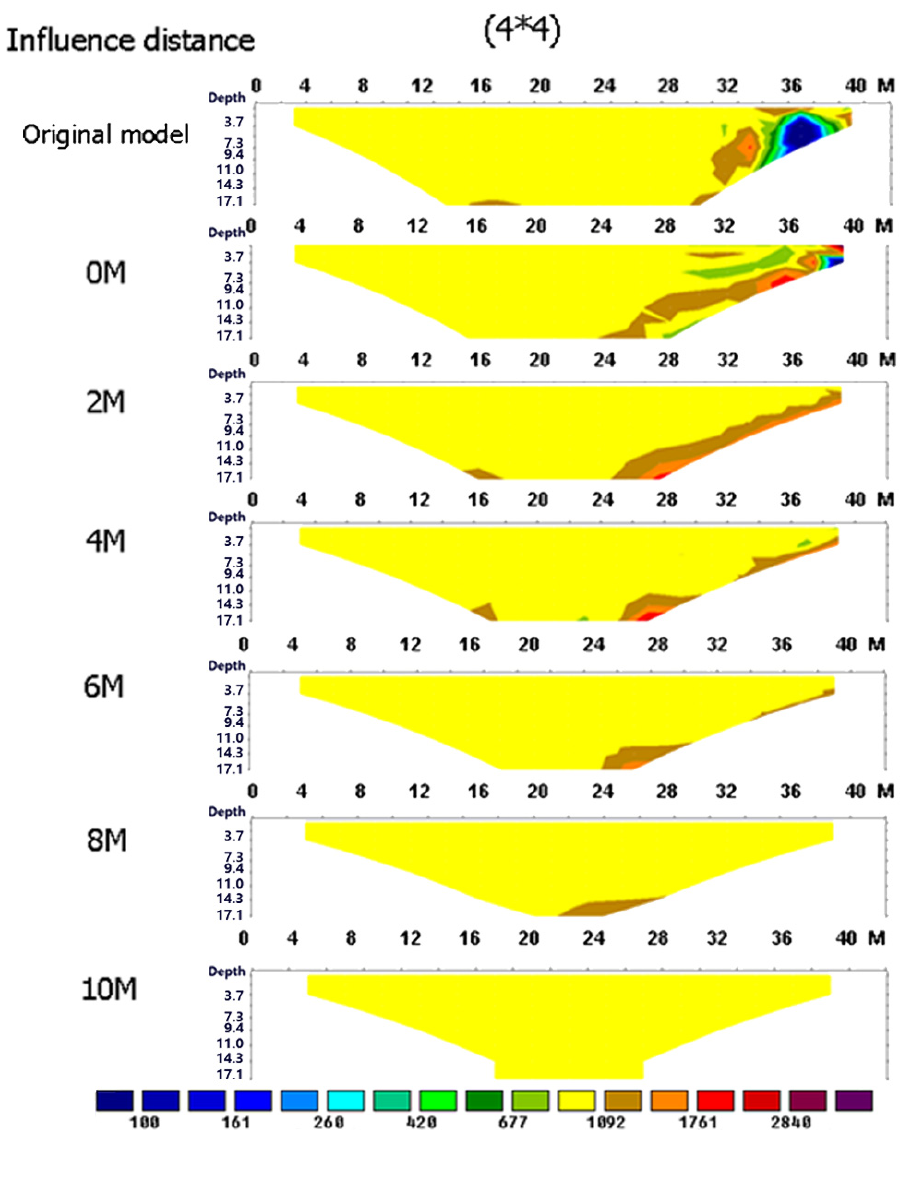
Figure 10. The influence situation of the boundary effect with different medium sizes. ( a ) medium size 2 × 2; ( b ) medium size 4 × 4.